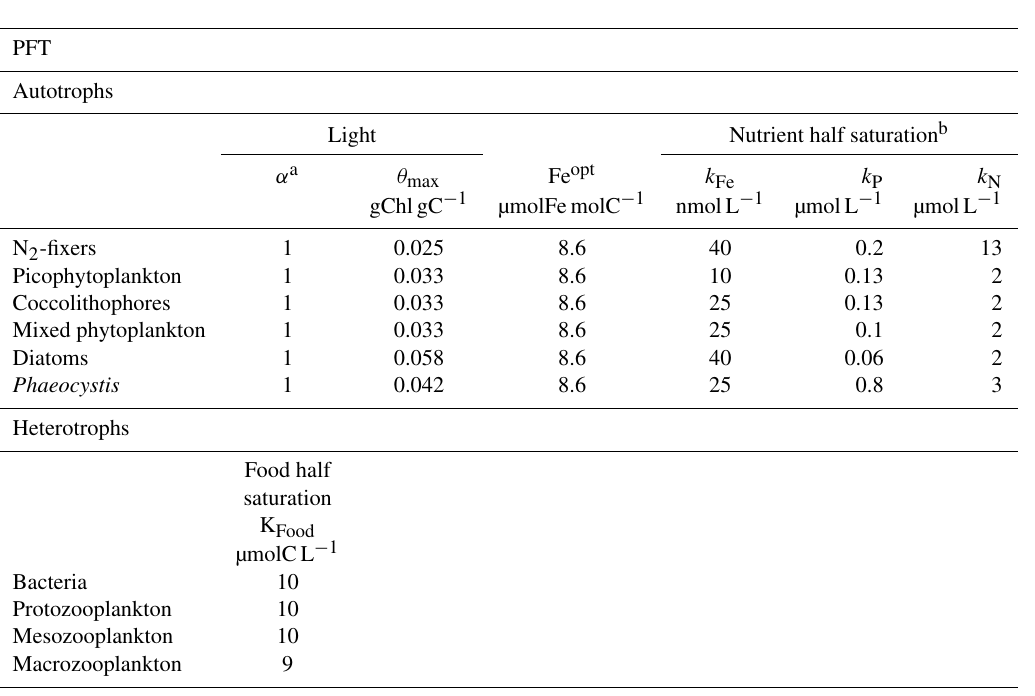
Table 2. Model parameters constraining the resource limitations of growth rates. See text and model equations in the Supplement for definitions of parameters.